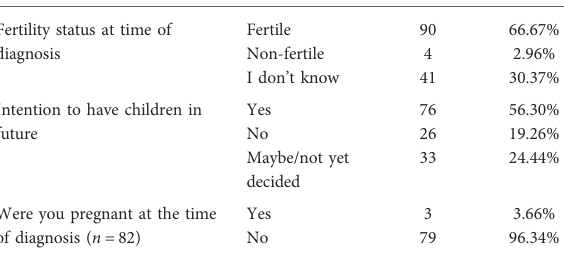
TABLE 2 The perception of being fertile and the desire to have children in the